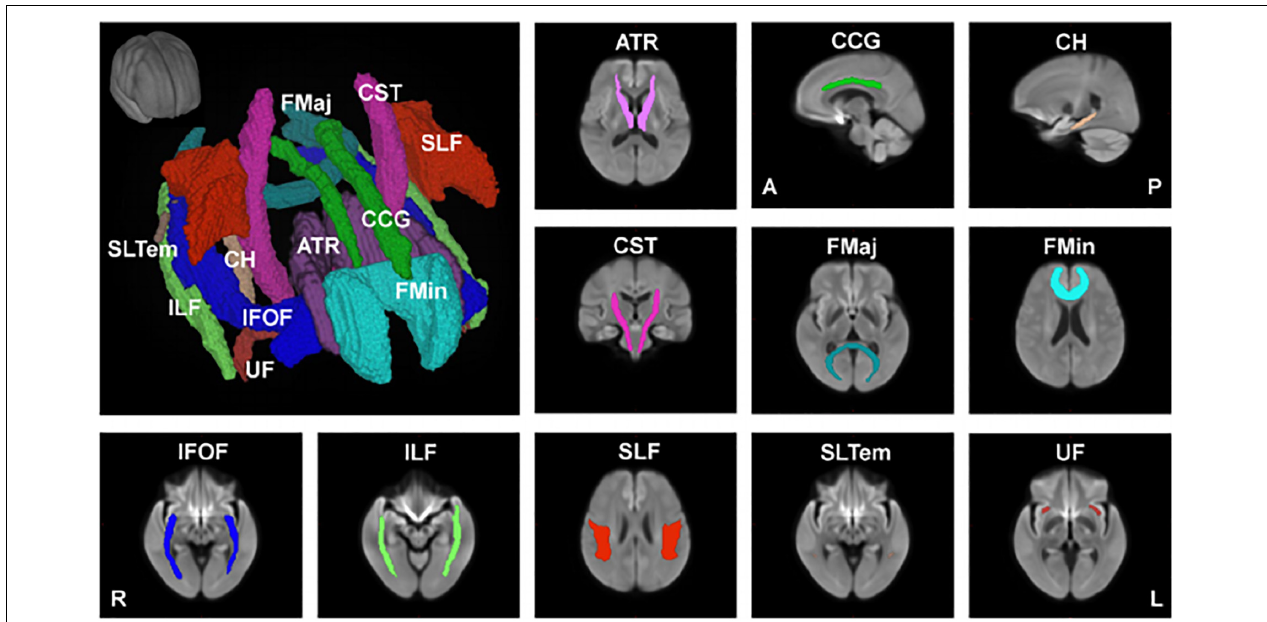
FIGURE 2 | Major anatomical tracts of the brain. Major fiber tracts based on the Johns Hopkins University – International Consortium for Brain Mapping (JHU-ICBM) atlas, warped onto the study’s population template space were used for the tract-level analyses of fiber density (FD), fiber cross-section (FC), and combined measure of fiber density and cross-section (FDC). ATR, anterior thalamic radiation; CCG, cingulum (cingulate gyrus); CH, cingulum (hippocampus); CST, corticospinal tract; FMaj, forceps major; FMin, forceps minor; IFOF, inferior fronto-occipital fasciculus; ILF, inferior longitudinal fasciculus; SLF, superior longitudinal fasciculus; SLTem, superior longitudinal fasciculus (temporal); UF, uncinate fasciculus. This figure is reproduced with permission from Choy et al.